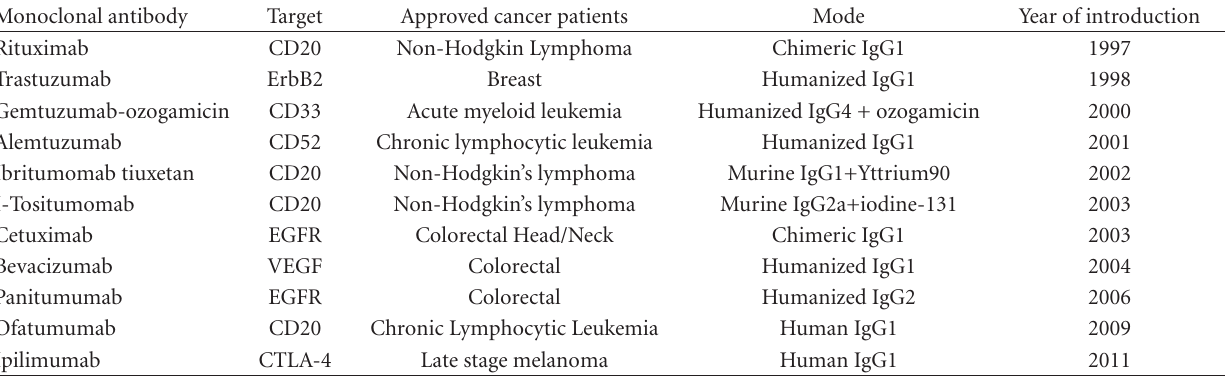
Table 1: FDA-approved MoAbs for cancer